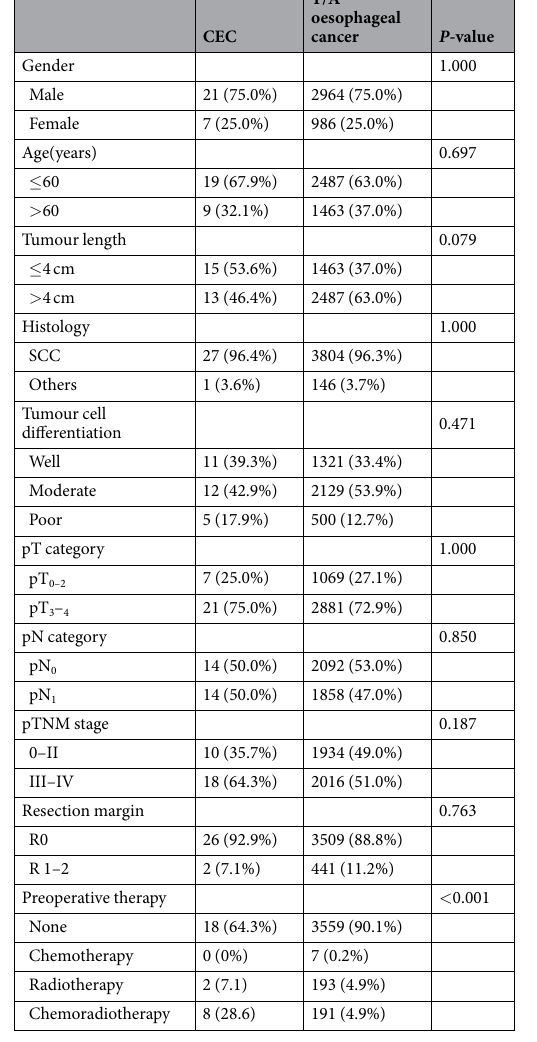
Table 2. Comparison of clinicopathological features between patients with cervical oesophageal cancer and patients with thoracic or abdominal oesophageal cancer who underwent surgery. Abbreviations: CEC, cervical oesophageal cancer; pT category, pathologic T category; pN category, pathologic N category; pTNM stage, pathologic TNM stage; R0, complete tumour resection; R1, microscopic residual tumour; R2, macroscopic residual tumour; SCC, squamous cell carcinoma; and T/A, thoracic or abdominal. The TNM stage was based on the sixth edition of the American Joint Committee on Cancer staging system for oesophageal